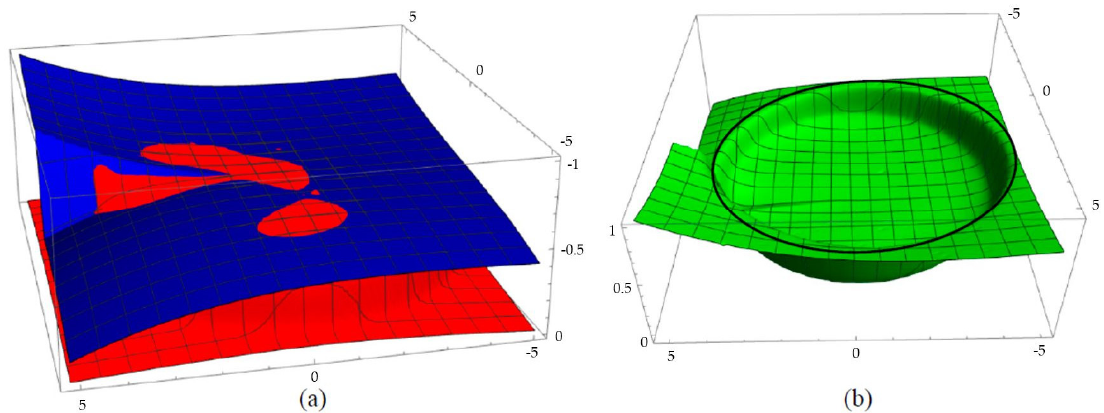
Figure 6. ( a ) Overlay of nominal surface (blue) and measured surface (red); ( b ) difference surface. The black circle indicates the nominal aperture.